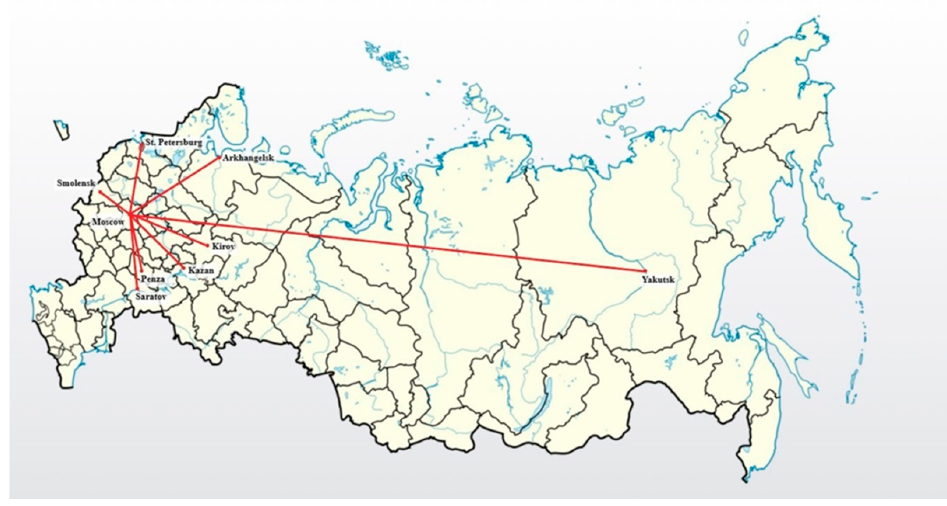
Figure 1. Regions of online medical student survey in Russia.